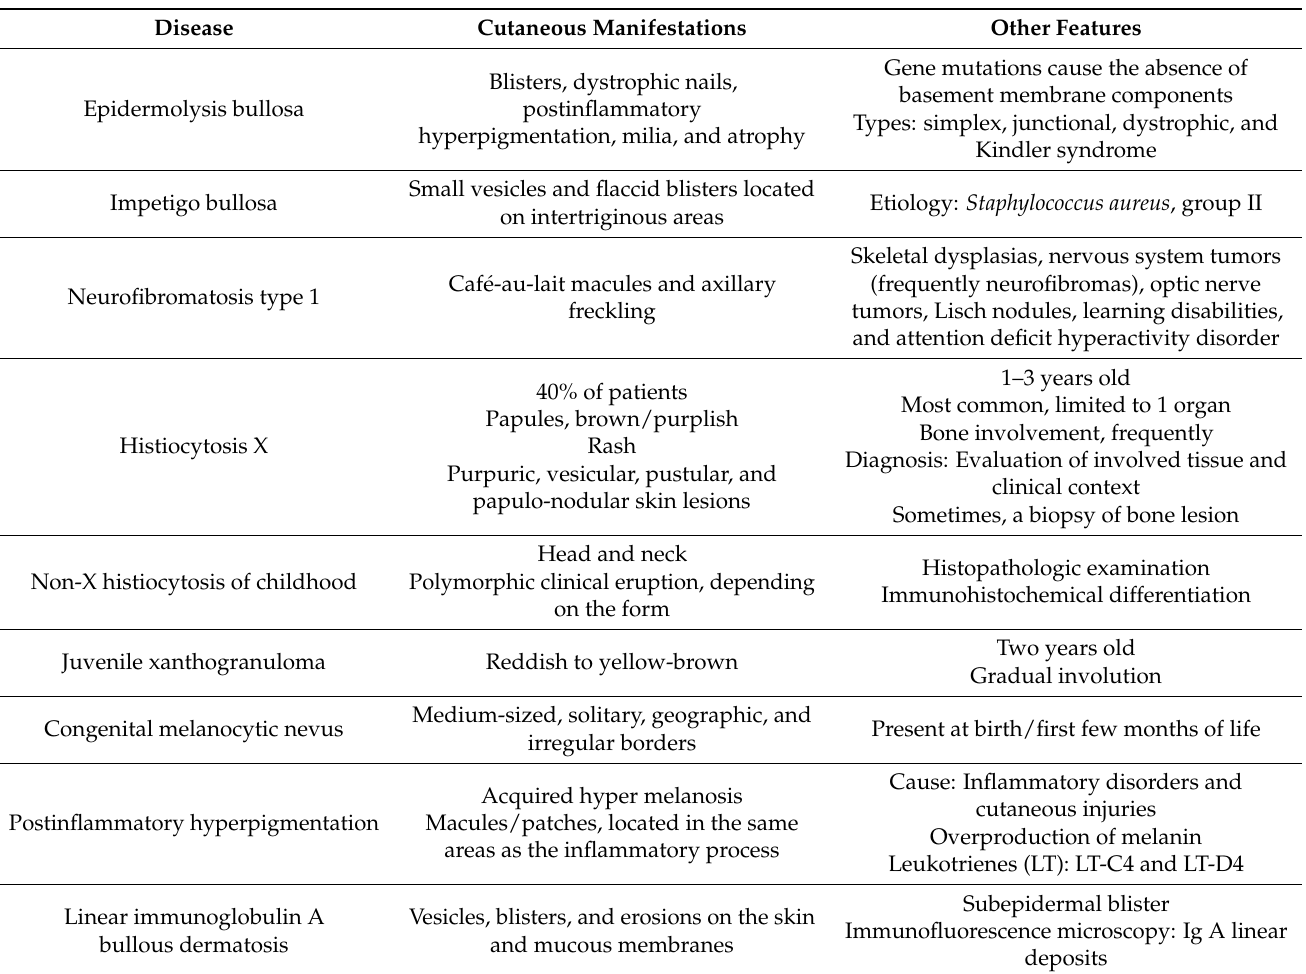
Table 2. Differential diagnosis of CM in